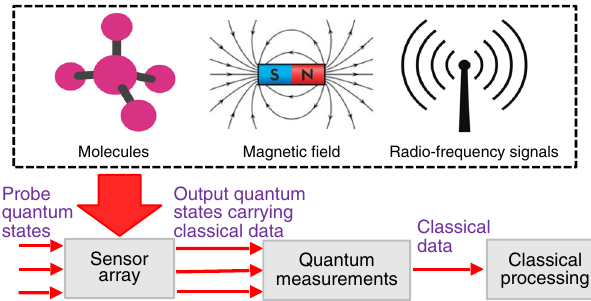
FIG. 1. Schematic of supervised learning based on data generated from sensors. The output quantum states carry classical data about the object under